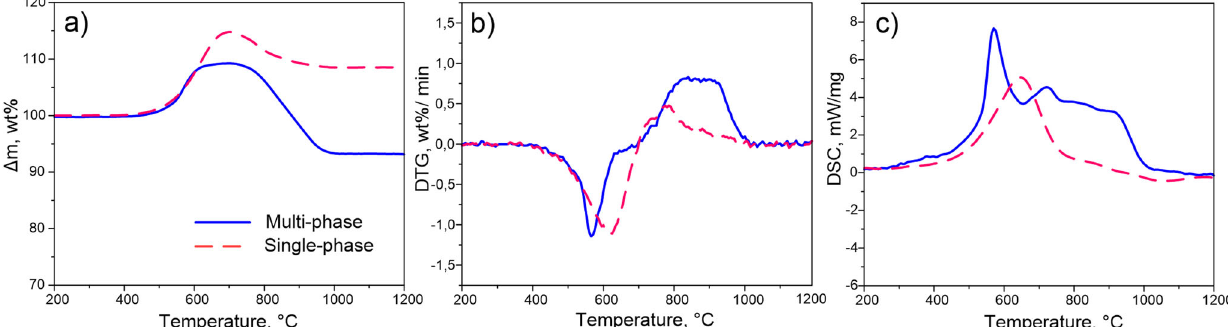
Fig. 8 Results of differential thermal analysis. a TG, b DTG, and c DSC in the air for two types of samples, namely multi-phase (blue solid curves) and single-phase (red dashed curves).